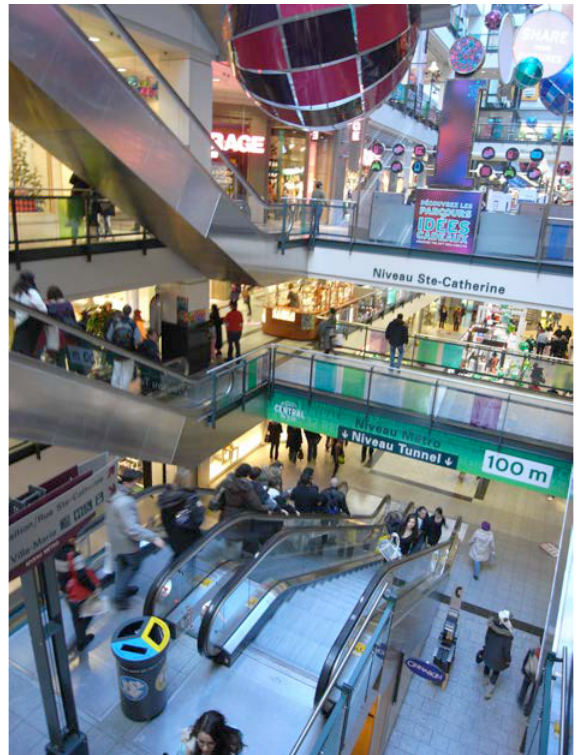
Figure 2. The Underground system is a pedestrian walkway system connecting buildings, but also an assemblage of connected multi-level shopping